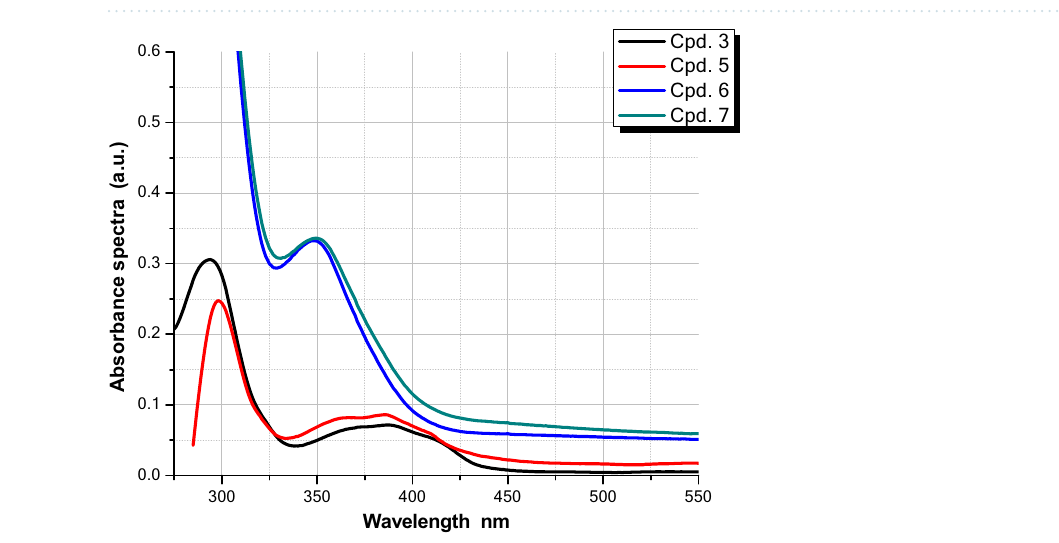
Figure 6. Frontier molecular orbitals involved in the electronic absorption transitions of compound 5 calculated at TD-B3LYP/6-31G(d,p) level of theory.